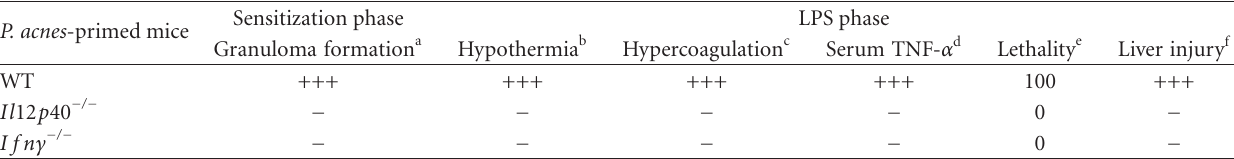
Table 2: Importance of IL-12-IFN- γ axis for in vivo LPS sensitization by P. acnes treatment. Mice with various genotypes were sequentially administered with P. acnes and LPS. At day 7 after P. acnes priming, hepatic granuloma formation was determined by histological analyses.